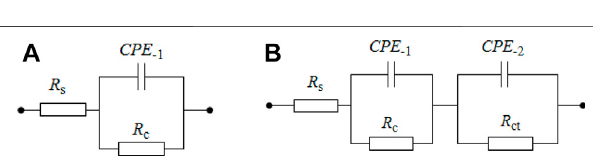
FIGURE 8 | The equivalent circuit used to fi t the EIS data. (A) used for one time constant in EIS, (B) used for two time constants in EIS.